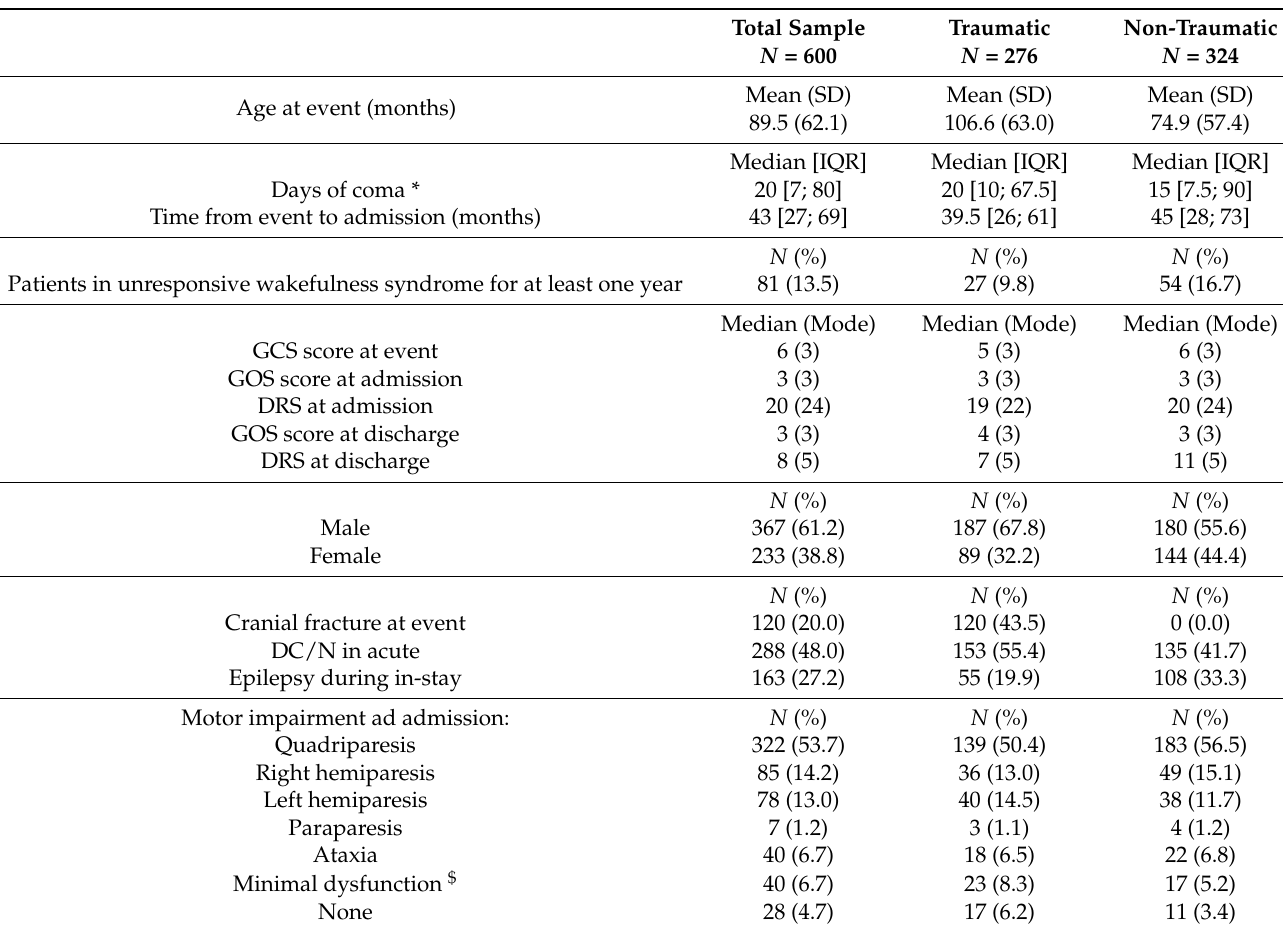
Table 1. Clinical and demographic characteristics of the total sample and the two groups divided by traumatic/non- traumatic etiology. Description includes the symptoms associated with the primary motor disorder and the need for decompressive craniotomy/neurosurgery (DC/N) in acute.